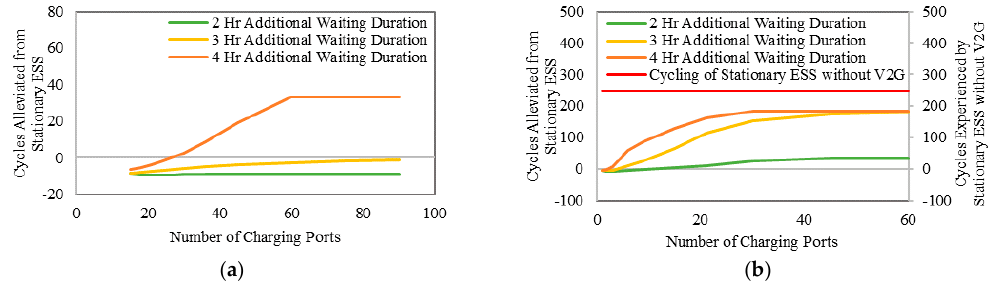
Figure 12 . Cycling for load-balancing alleviated from stationary ESS by vehicle-to-grid (V2G) operation considering ( a ) level 2 and ( b ) DC fast charging rate limitation.